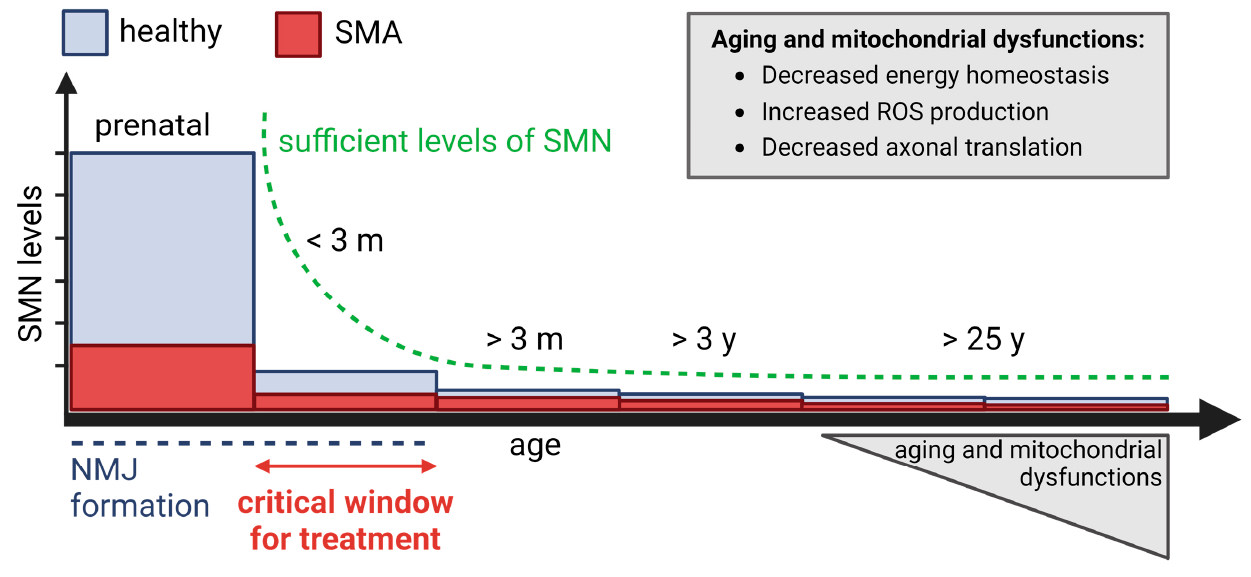
Figure 4. Cellular aging and mitochondrial aberrations may decrease MN performance below their functional threshold in adult SMA. SMN protein functions are mainly required during the develop- ment; indeed, also in healthy individuals the levels of SMN protein drop already after birth by 6.5-fold. SMN is also required in the adulthood but only at low levels, not significantly different between healthy and SMA individuals [12]. Many aging factors, such as decreased bioenergetics, increased ROS production and decreased axonal translation, may drop the function of NMJs just slightly below the threshold, ultimately causing SMA in adults. The figure was created with